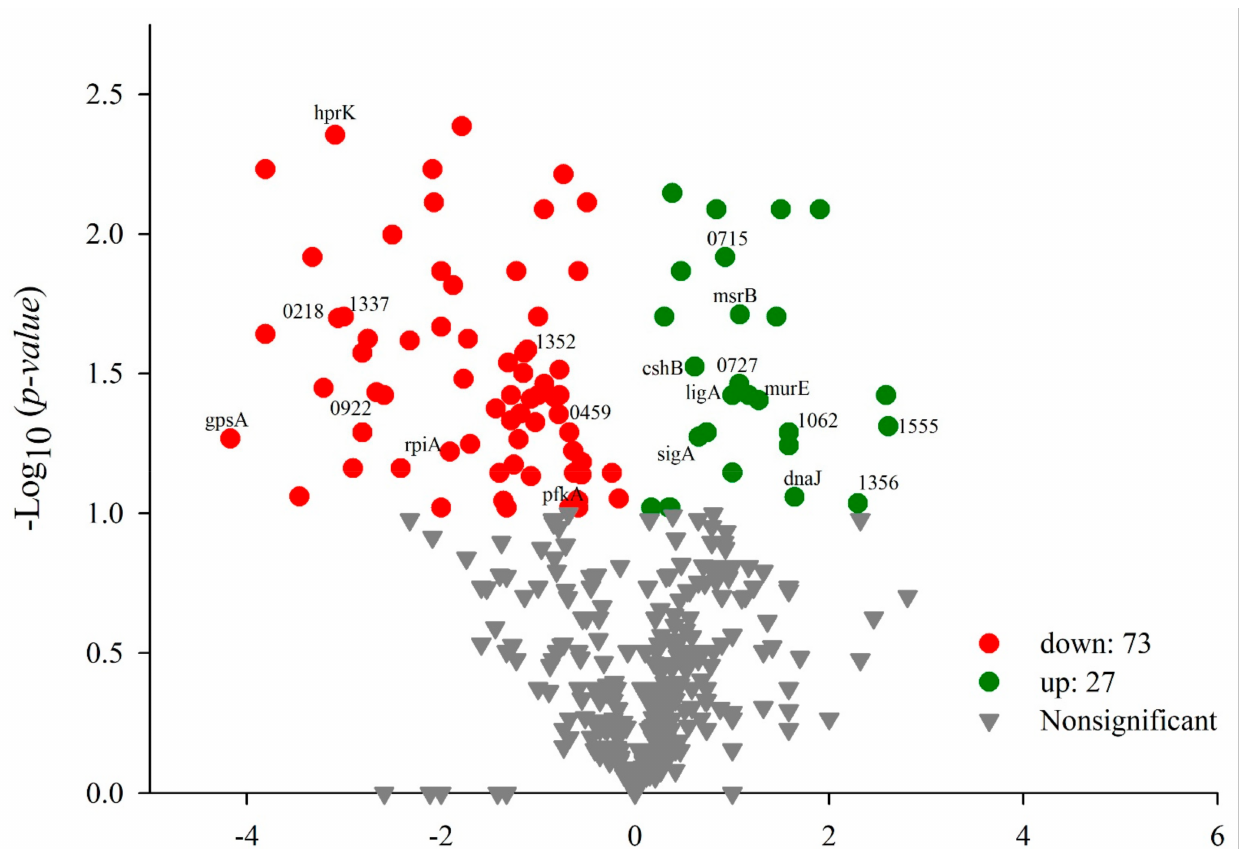
Figure 4. Volcano plot: change level of treatment and control proteins. Red dot, downregulated; green dot, upregulated; and gray dot, nonsignificant ( t -test p <